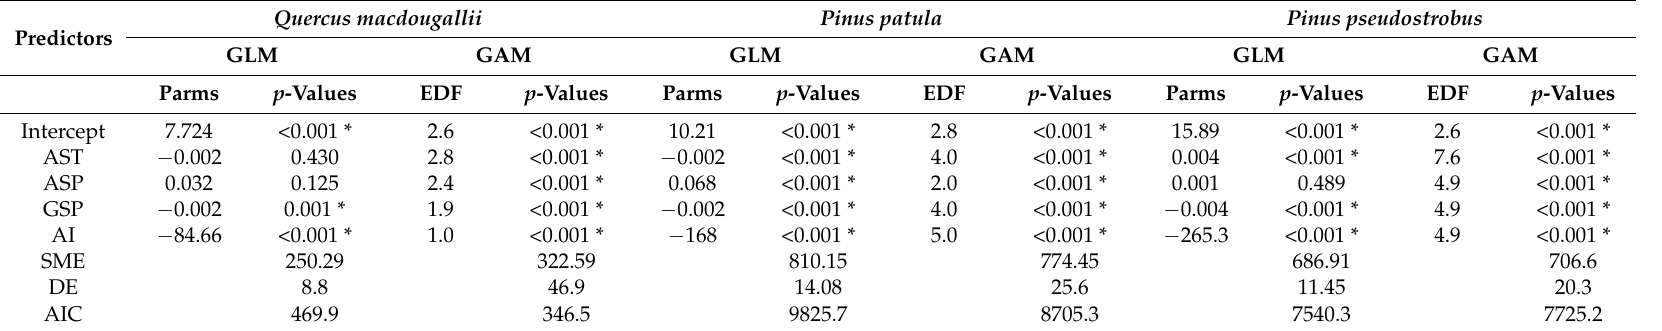
Table 2. Coefficients and adjustment indicators for GLMs and